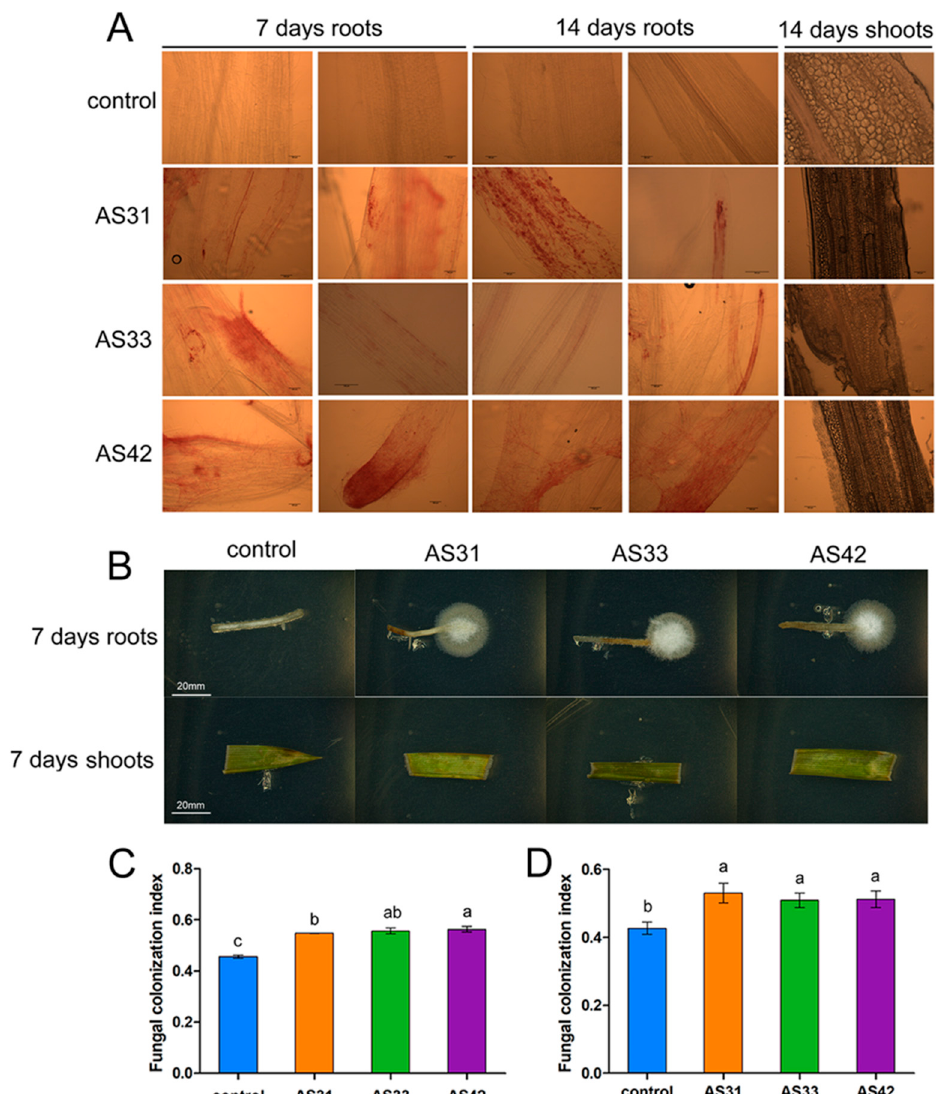
Figure 2. Colonization of strains AS31, AS33, and AS42 in rice roots and shoots after 7 and 14 days of inoculation. ( A ), Magenta staining was used to monitor the inoculation sites on rice roots and shoots. Bars = 100 µm. The three fungi successfully colonized rice roots and produced a large number of hyphae, but these fungi did not colonize rice leaves. ( B ), Isolation of strains AS31, AS33, and AS42 from the inoculated rice roots and shoots. ( C , D ), Fungal colonization index at 7 ( C ) days and 14 ( D ) days after inoculation. Data represent the means ± SD of three biological replicates per treatment. Different letters indicate significant differences according to Duncan’s multiple range test. Values of p < 0.05 are considered significant.